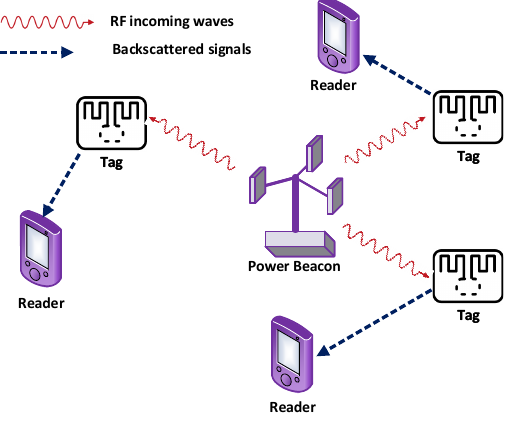
Figure 29. Wirelessly powered